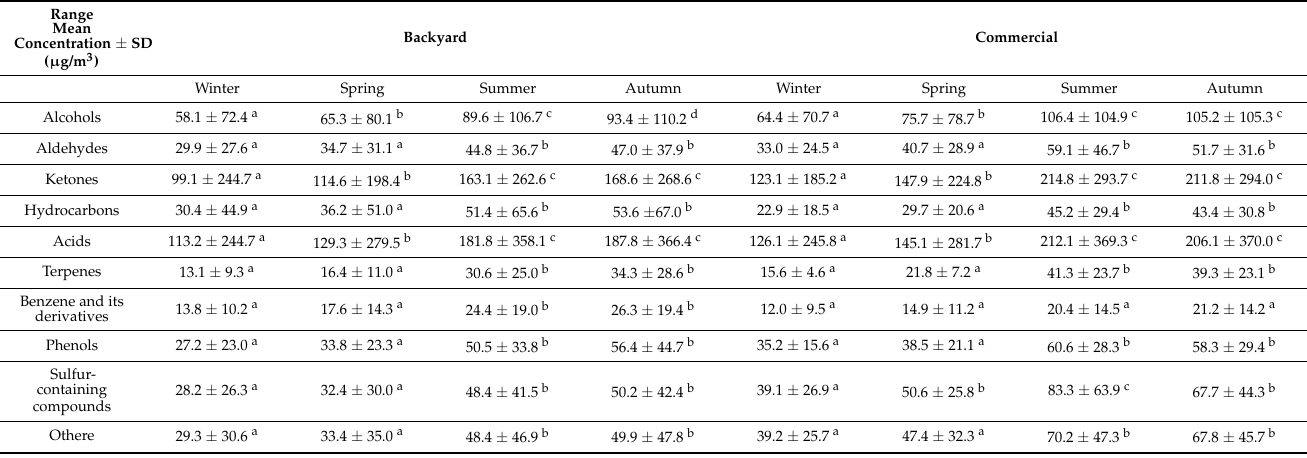
Table 7. Summary for averages of particular groups of chemical compounds in particular seasons of the year, depending on the type of rearing, taking into account the standard